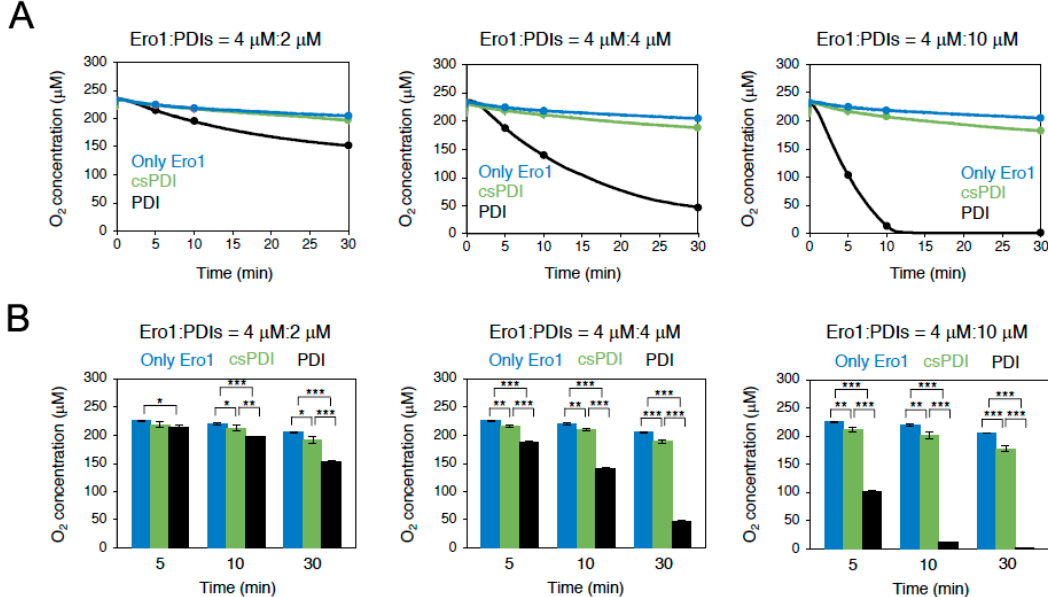
Figure 3. ( A ) Oxygen consumption by Ero1 (4 µM) during the oxidation of conotoxin-specific PDI (csPDI) or PDI (2, 4 or 10 µM each; left, middle and right panel, respectively) in the presence of a reducing agent (10 mM GSH). ( B ) Quantification and statistical analyses of the dissolved oxygen concentration at indicated time points in A ( n = 3, means ± standard deviation (SD)). * p < 0.05; ** p < 0.01; *** p < 0.001.